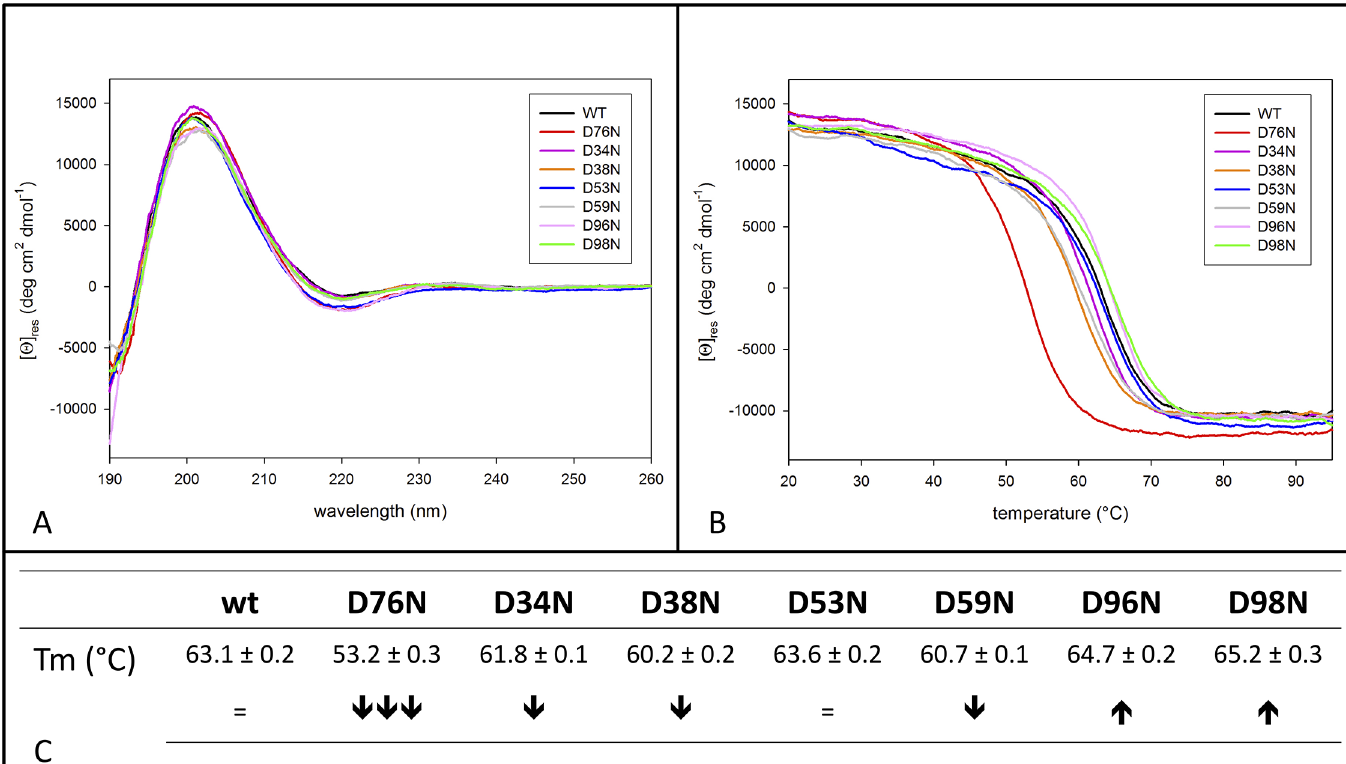
Fig 2. Thermodynamic stability of β 2m D-to-N variants. (A) Comparison of the CD spectra of wt β 2m and D-to-N variants. (B) Thermal stability assessed by CD experiments in the far-UV region. (C) Tm values are determined as the minima of the first derivative of the unfolding profiles, each thermal unfolding was repeated four times. Standard deviations were calculated and are shown for each Tm. Arrows highlight graphically the Tm